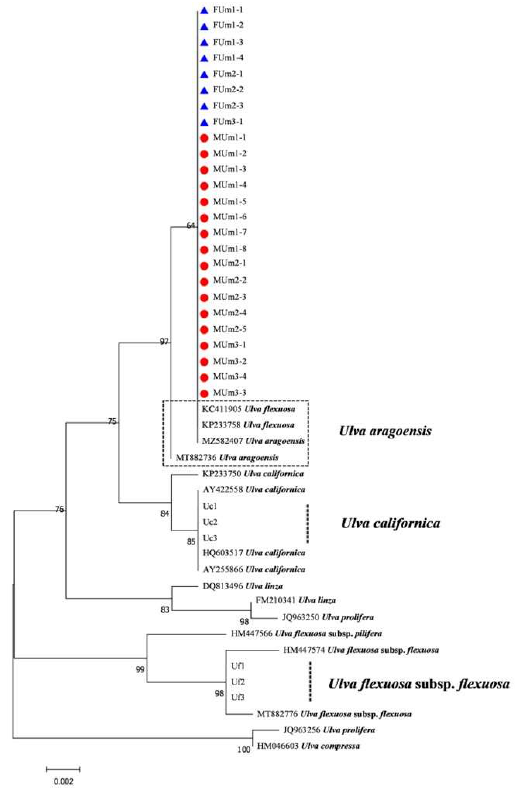
Figure 6. Maximum likelihood tree constructed from the analysis of rbc L gene sequences of U. aragoensis samples and those downloaded from GenBank.